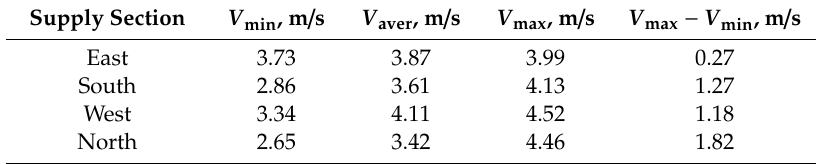
Figure 2. Time evolution of measured velocity at four points located near four supply sections: ( a ) east, ( b ) south, ( c ) west, and ( d ) north of fan coil #4. Table 4. Velocity characteristics at four points located near four supply sections of fan coil #4.